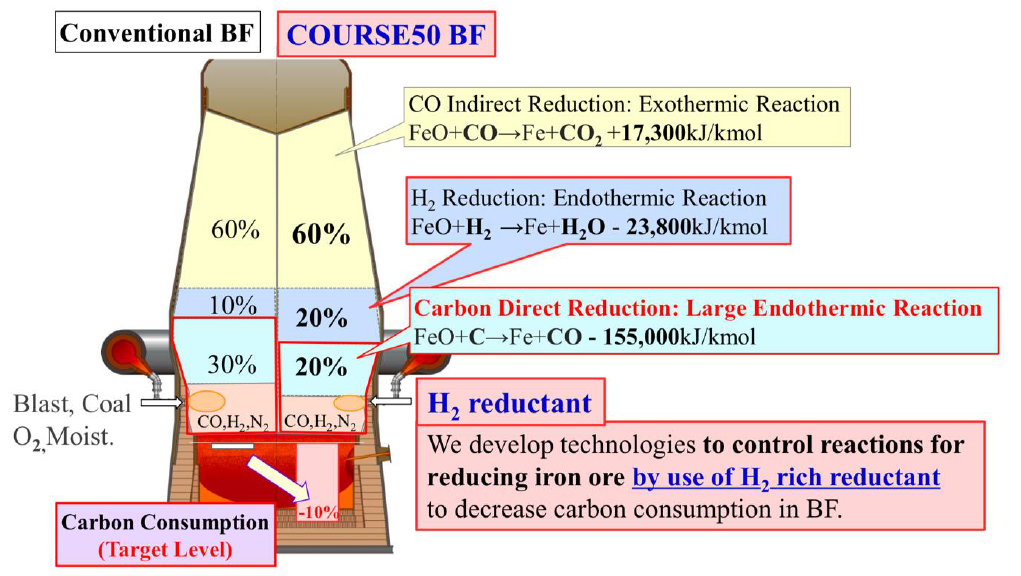
Figure 27. Concept of “iron ore hydrogen reduction reinforcement” in the Japanese COURSE50 program (source: ISIJ).